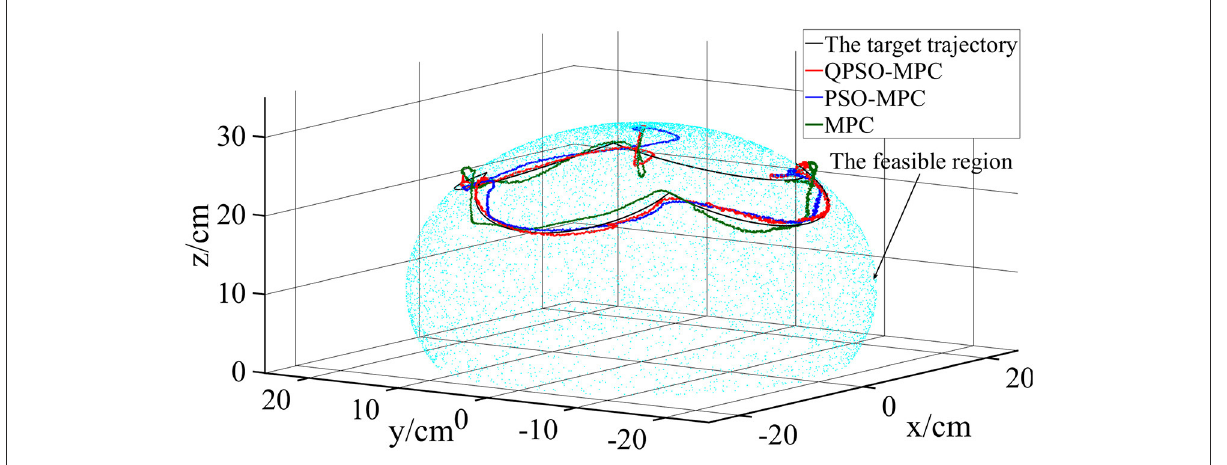
FIGURE10 Experiment results of the polyline trajectory